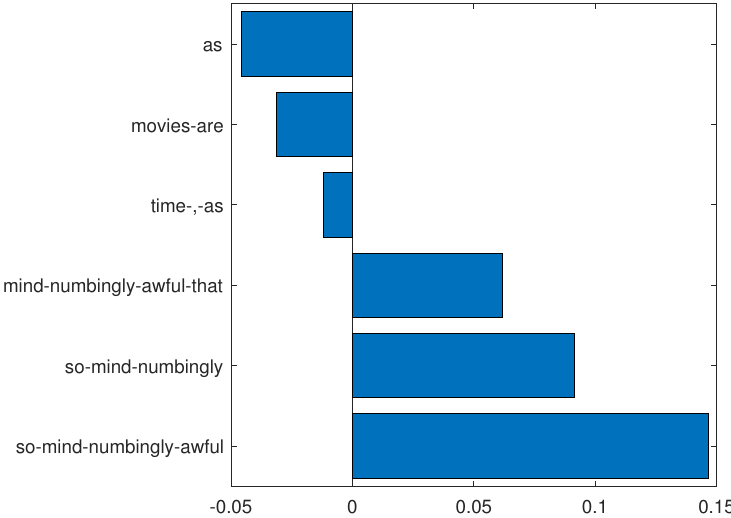
Figure 9. N-grams determined from R 26 and the following “tweet”: “so mind-numbingly awful that you hope britney won’t do it one more time, as far as movies are concerned”. The sum of the n-grams linear contributions is